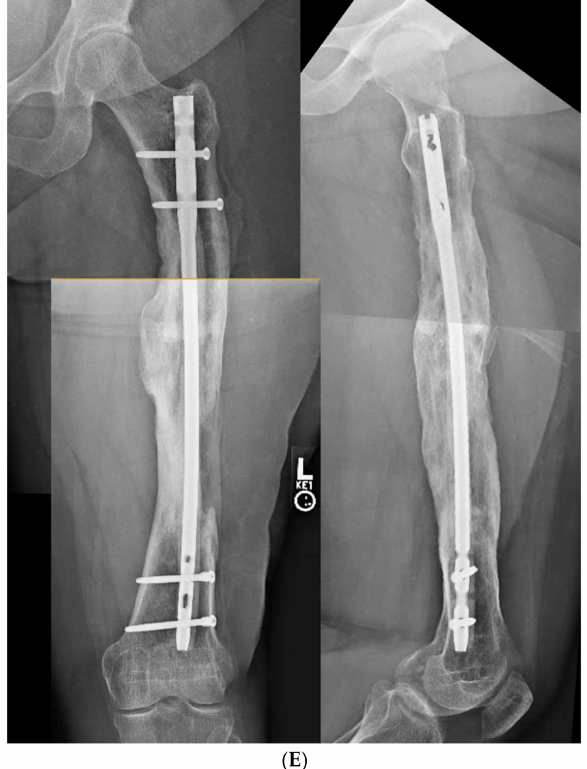
Figure 6. ( A ) Middle-aged female with 26 years of an infected draining sinus of the left femur with malunion and shortening. The intersection of the two blue lines represents the CORA of the proximal and distal diaphyseal segments (C1). A CORA outside of the deformity reveals translation in addition to angulation. The intersection of the green line with each blue line represents an alternative where the central deformed segment is also incorporated into the analysis, revealing two CORA center points for double-level osteotomy (Ca and Cb). ( B ) The patient was found to have retained hardware and a bone sequestrum. Sequestrectomy with antibiotic local delivery via a coated intramedullary nail with concomitant systemic antibiotics would promote infection eradication. ( C ) The patient underwent double-level focal dome osteotomy at the time of initial debridement. The patient had two sequential debridements over 10 days. Stabilization using an interlocking antibiotic coated nail was placed during the final debridement. ( D ) Five months postoperative, where the distal osteotomy was autogenous-grafted from the patient’s contralateral femur due to the persistent osteotomy gap. Chronic suppression oral antibiotics were recommended; patient voluntarily stopped antibiotics at 24 months. ( E ) Three-year final follow-up with normal serological markers and no sign of recurrence. Osteotomies healed. Soft tissue